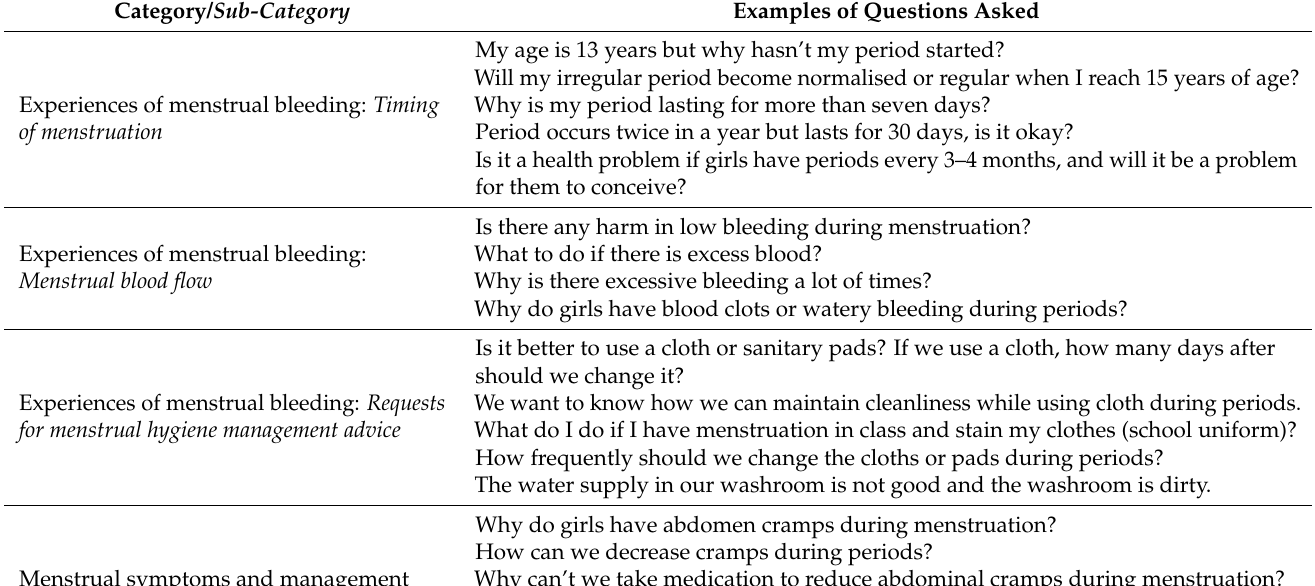
Table 3. Examples of menstruation-related questions submitted anonymously by students in four schools in Bangladesh 2017–2018, classified by categories and sub-categories. Category/ Sub-Category Examples of Questions